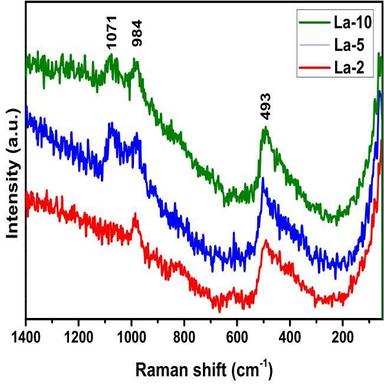
Raman spectra of La-TUD-1 samples.